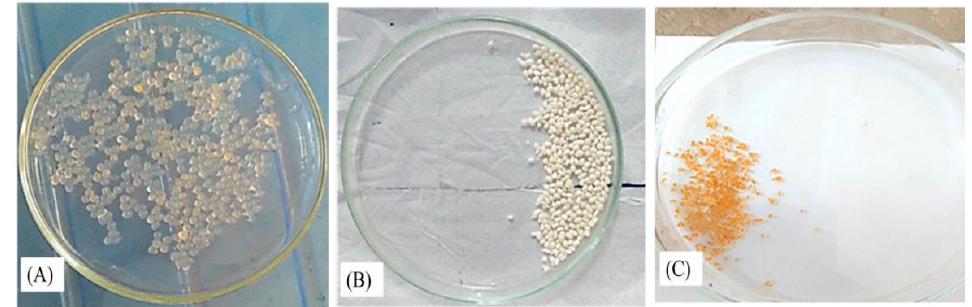
Figure 3. Schematic diagram representing ( A ) freshly prepared beads before drying, ( B ) freeze-dried beads, and ( C ) oven-dried